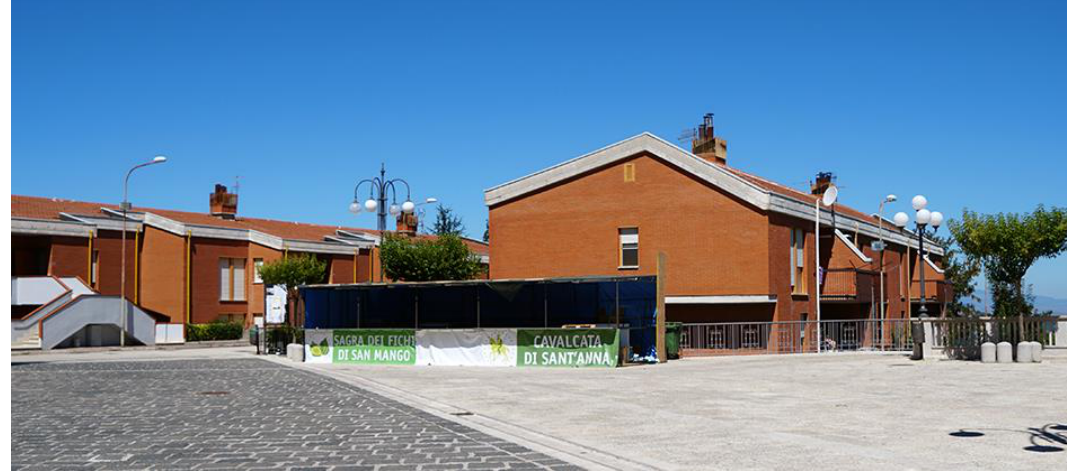
Figure 57. San Mango sul Calore: “villaggio italo-canadese” new homes built with the help of Canadians (photos by [35,36]).